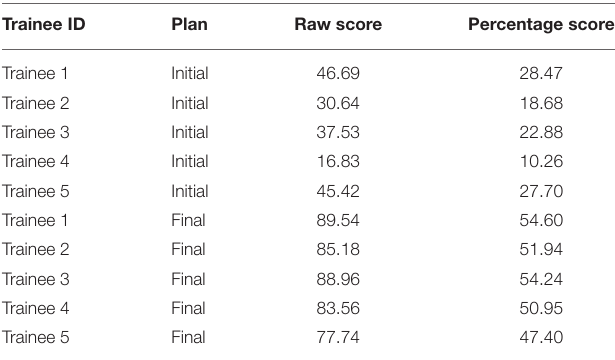
TABLE 2 | Scores of the benchmark plan for each trainee before and (“Initial”) after (“Final”)